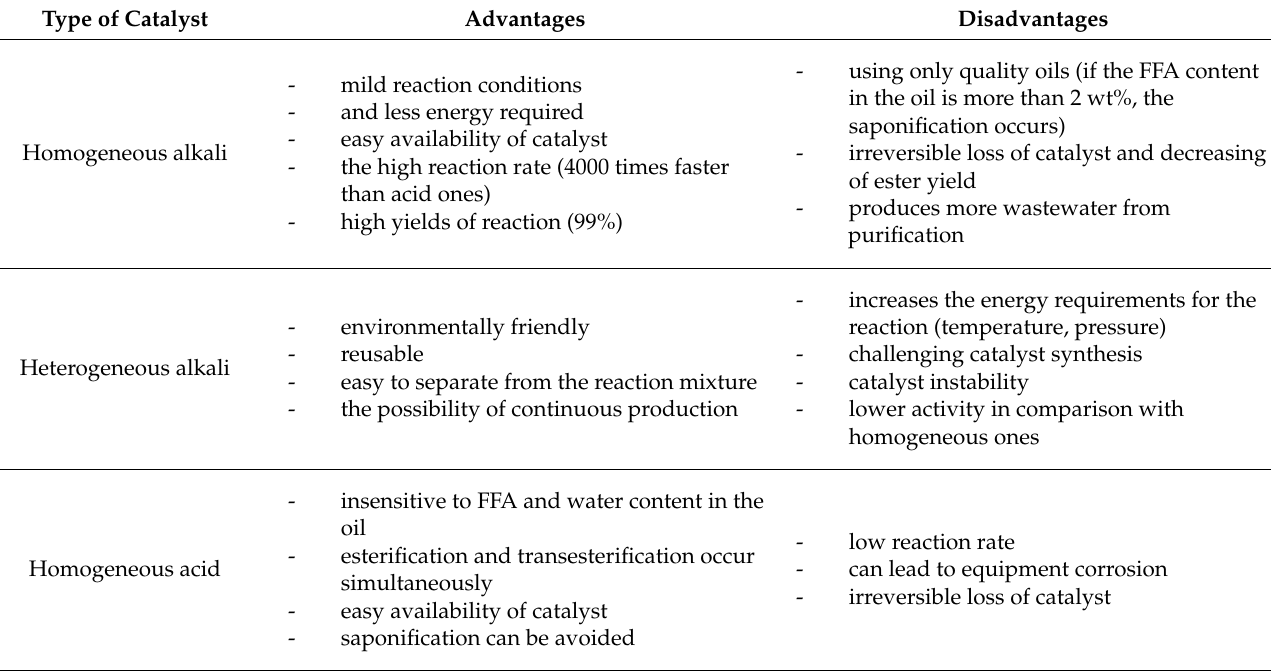
Table 4. Overview of the catalysts used in